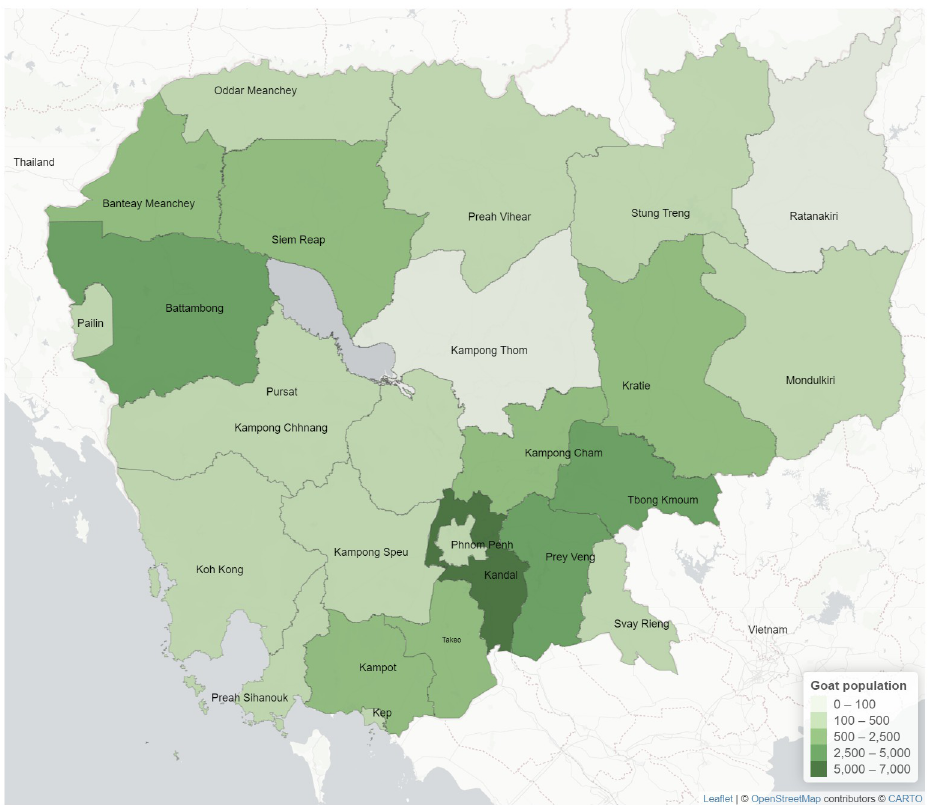
Fig 1. Density map indicating Cambodian goat population in 2018. Map shapefiles sourced from https://www.diva- gis.org/gdata.